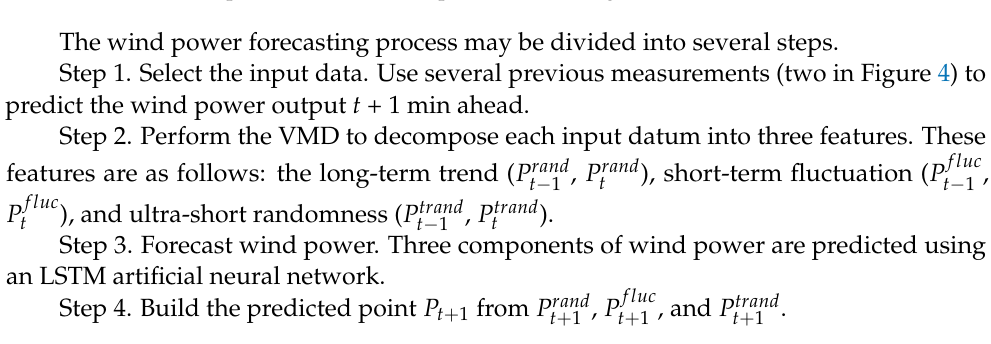
Figure 4. Schematic representation of wind power forecasting.